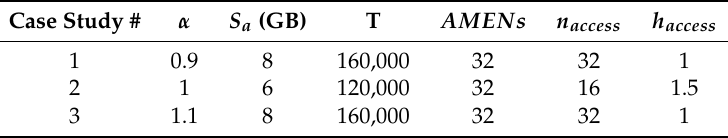
Table 2. Simulation settings for the considered case